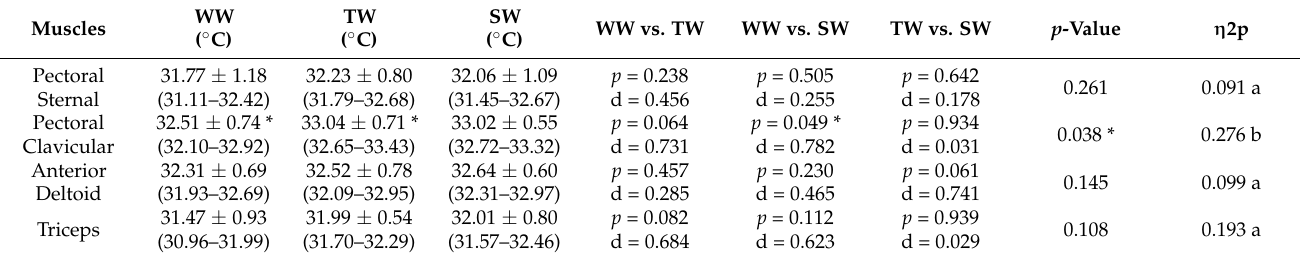
Table 2. Skin temperature over active muscles in different types of warm-up (mean ± SD and CI 95%).